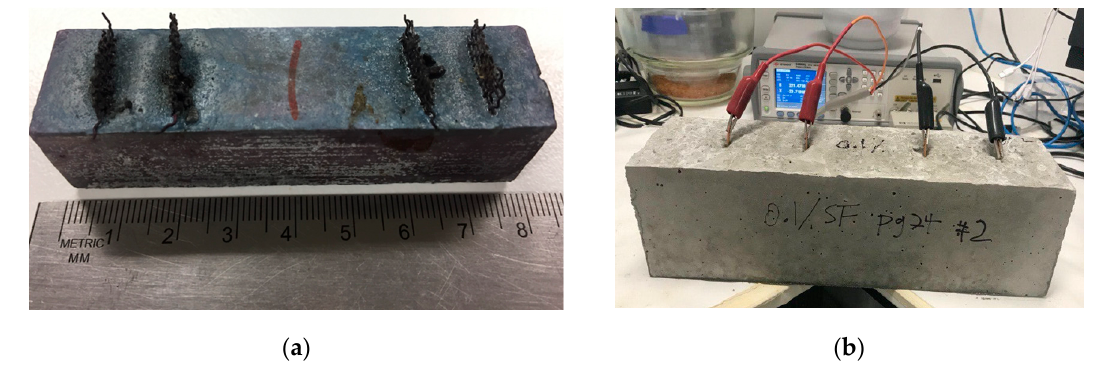
Figure 3. Cement paste-based sensing blocks: ( a ) Size 1; and ( b ) Size 2.